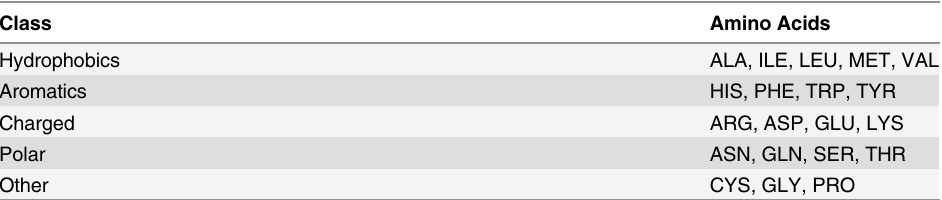
Table 2. Amino acid class definition.